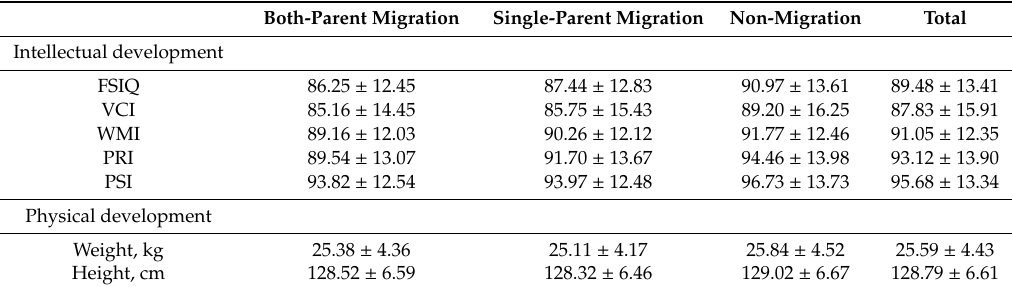
Table 2. Mean Scores on WISC-IV Test by migrant of parents a